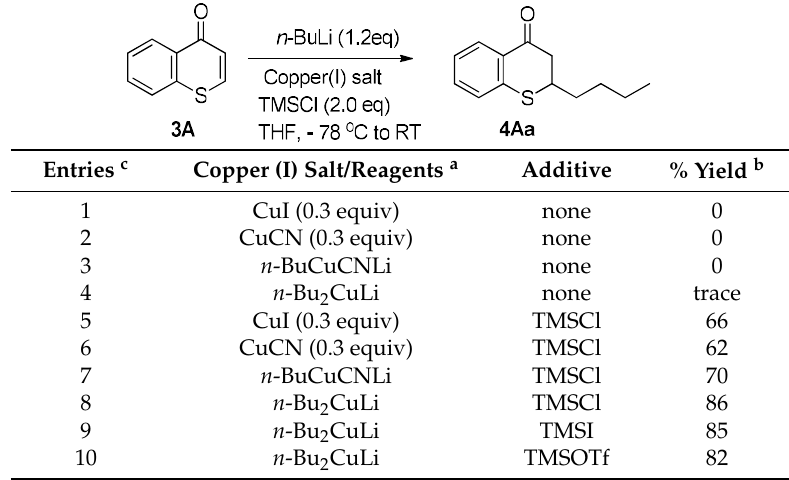
Table 1. Optimization of 1,4-Conjugate Addition of Alkylcuprates to Thiochromone.